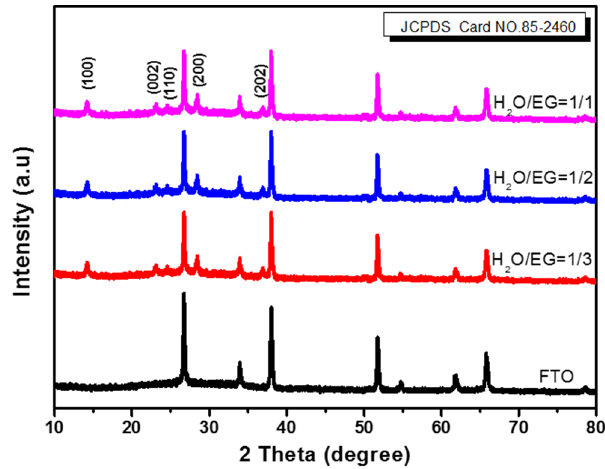
Figure 1. XRD pattern of h-WO 3 thin films prepared by hydrothermal method.